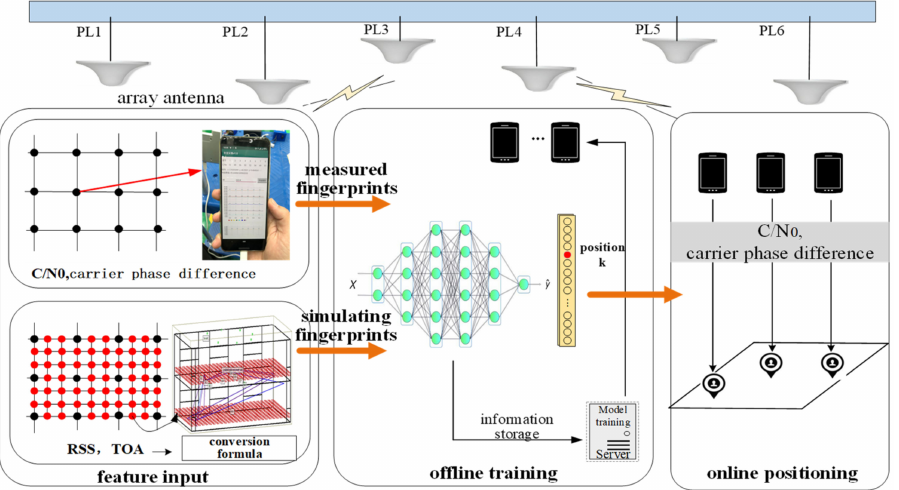
Figure 6. RT-ANN network